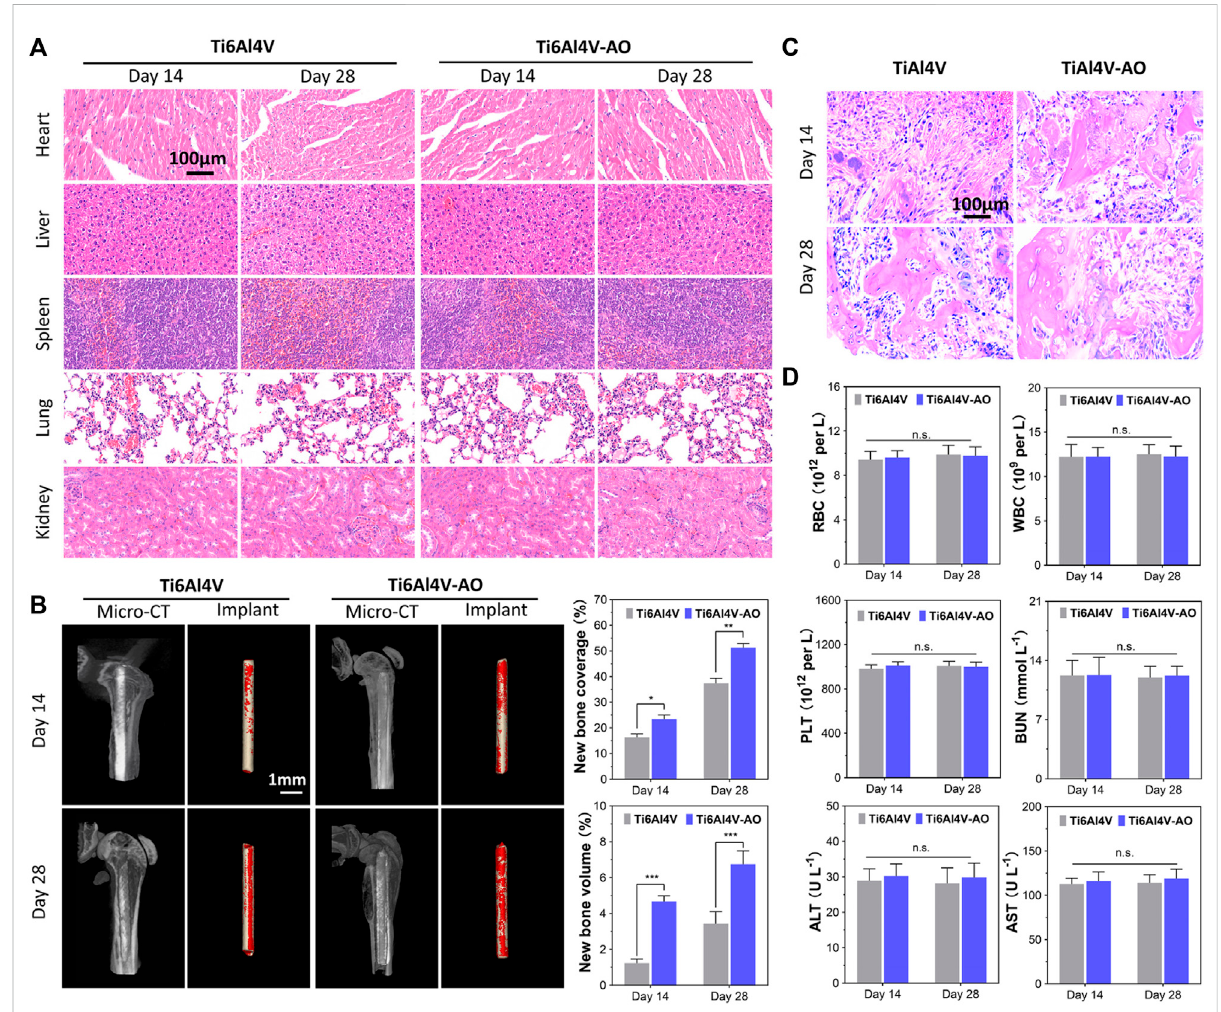
FIGURE 3 Evaluation of biocompatibility and osteogenesis of CSDP in mouse model. (A) Hematoxylin and eosin (HE) staining of mouse organs at 14 and 28 daysaftersurgery. (B) Osteogenesismorphologicalanalysisofmicro-CTinmousemodel. (C) HEstainingofbonetissuesectionsaroundimplants. (D) Mouse blood biochemical test. The complete blood data, including white blood cells (WBCs), red blood cells (RBCs), and platelets (PLTs). Blood levels of alanine aminotransferase (ALT) and aspartate aminotransferase (AST) as liver function markers. Blood urea nitrogen (BUN) as